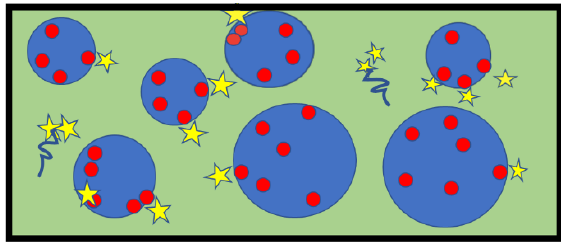
Fig. 8 . Electromagnetic Conversion channels in semiconductors and insulators. The hydrogen molecules in red are confined inside the blue nanocages, while the excitonic propagations (yellow stars) diffuse through the catalyst before being disintegrated by mutual collisions.